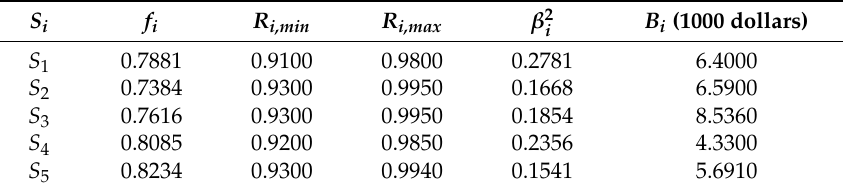
Table 5. Relevant data needed of the multi-objective mathematical